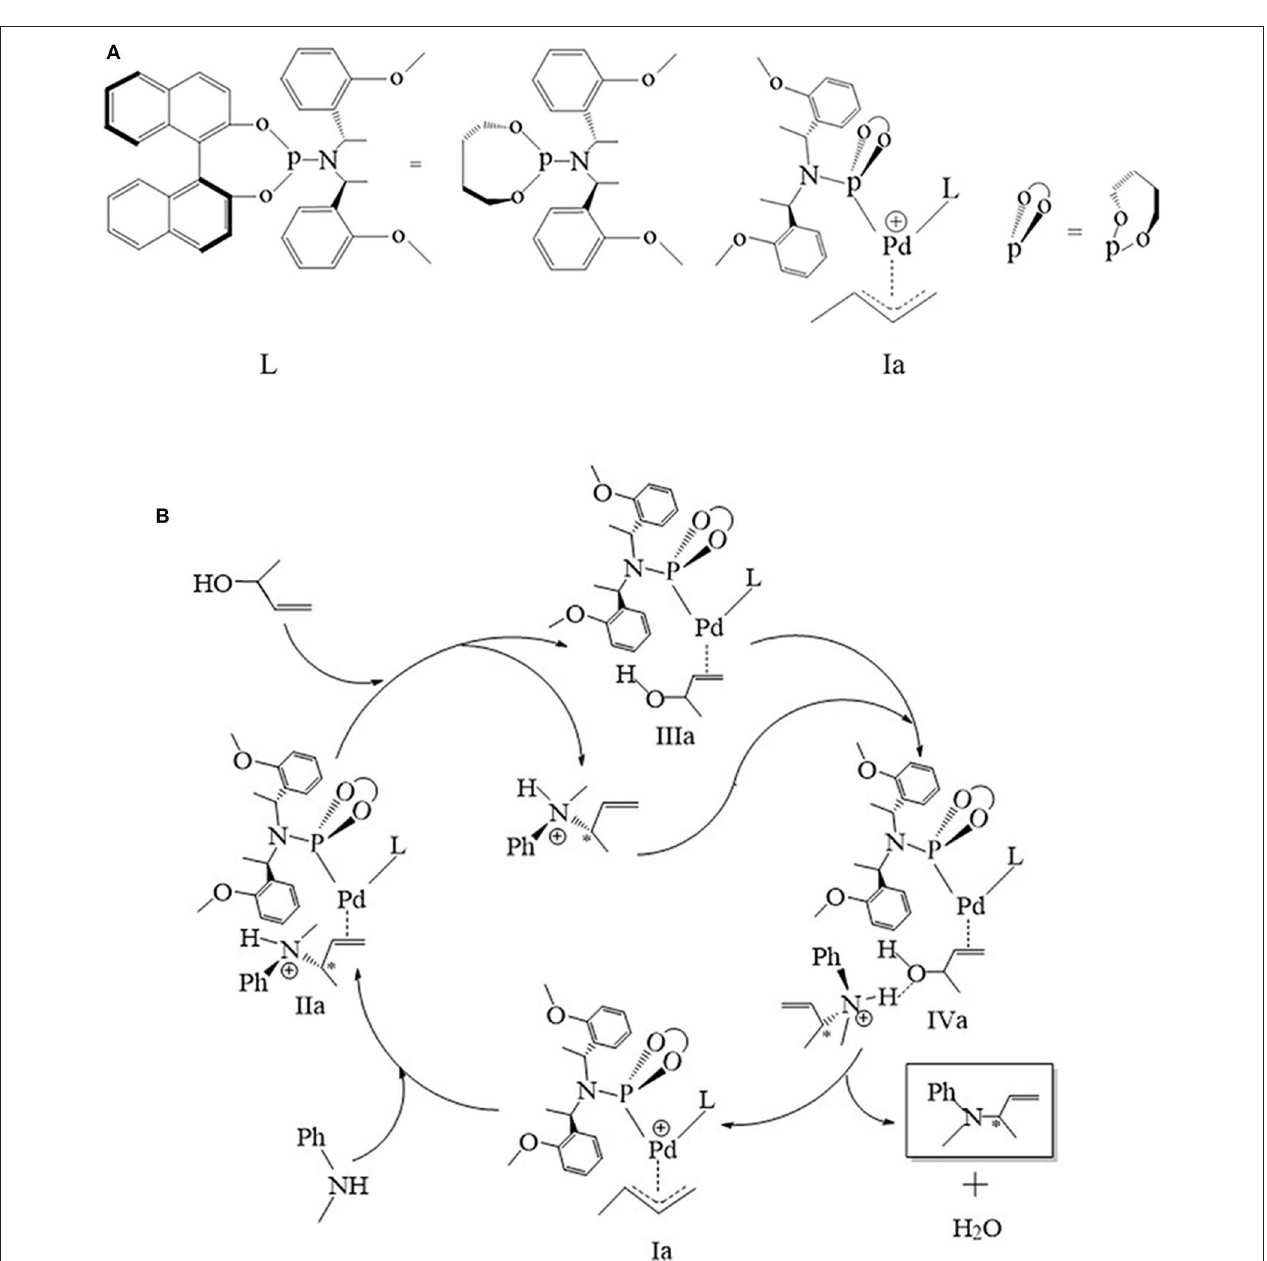
FIGURE 1 | (A) The structure of phosphoramidite ligand ( L ). (B) The schematic representation of the mechanism of palladium-catalyzed the 3-butene-2-ol amination reaction.